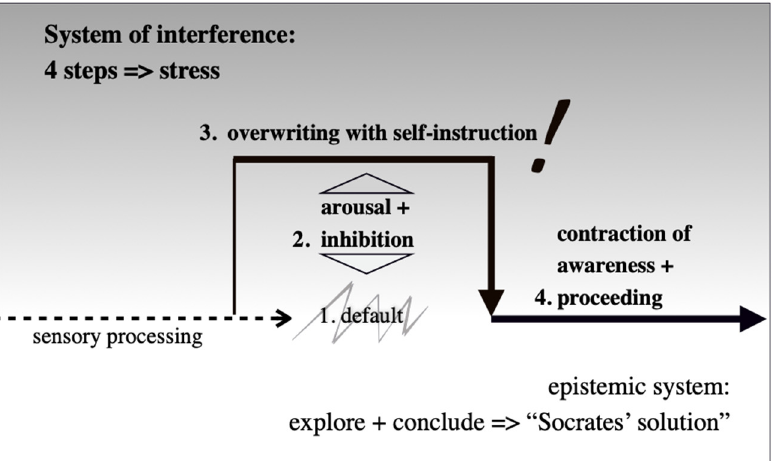
Figure 2. Model of the four steps of mental interference (according to Wagner [2007] 2021), modified graphics according to Klebanova (forthcoming), translated from German.